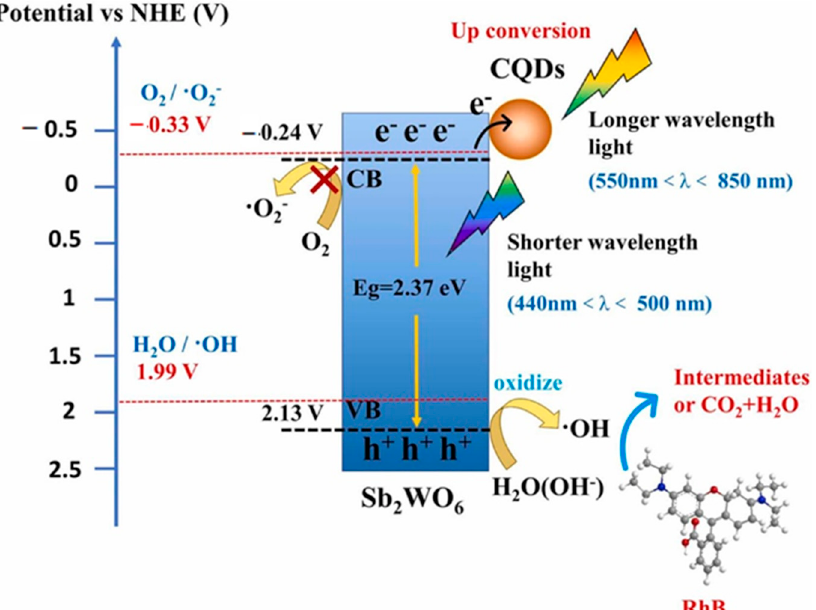
Figure 8. Proposed photocatalytic degradation mechanism by the CQDs/Sb 2 WO 6 photocatalyst (reprinted with permission from [124], 2022, Elsevier).